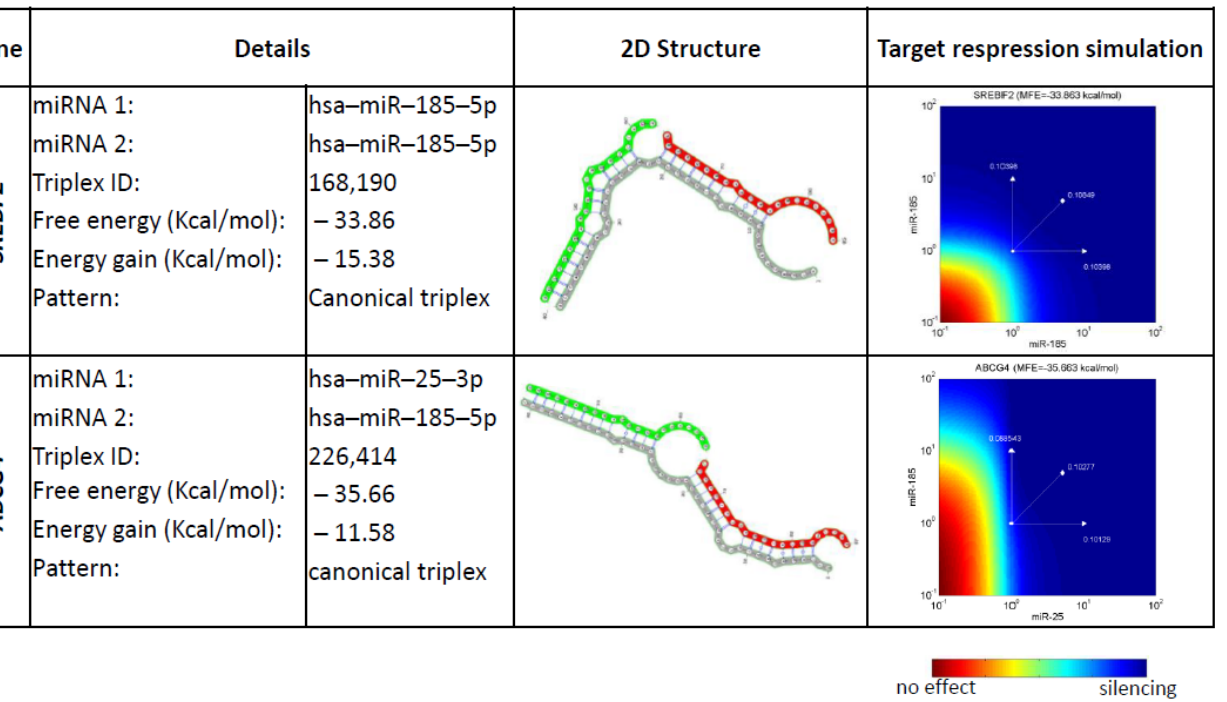
Figure 5. RNA triplexes formed by deregulated miRNAs and strong evidence target genes. 2D struc- ture is shown in the third column. Repression efficiency is color coded with red having no effect and blue having a silencing